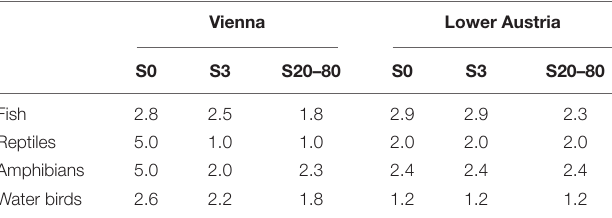
TABLE 3 | Overall scores per group for the different scenarios, based on both HBDs species and species protected by nature conservation laws and divided between the upstream part in Vienna and the downstream part in Lower